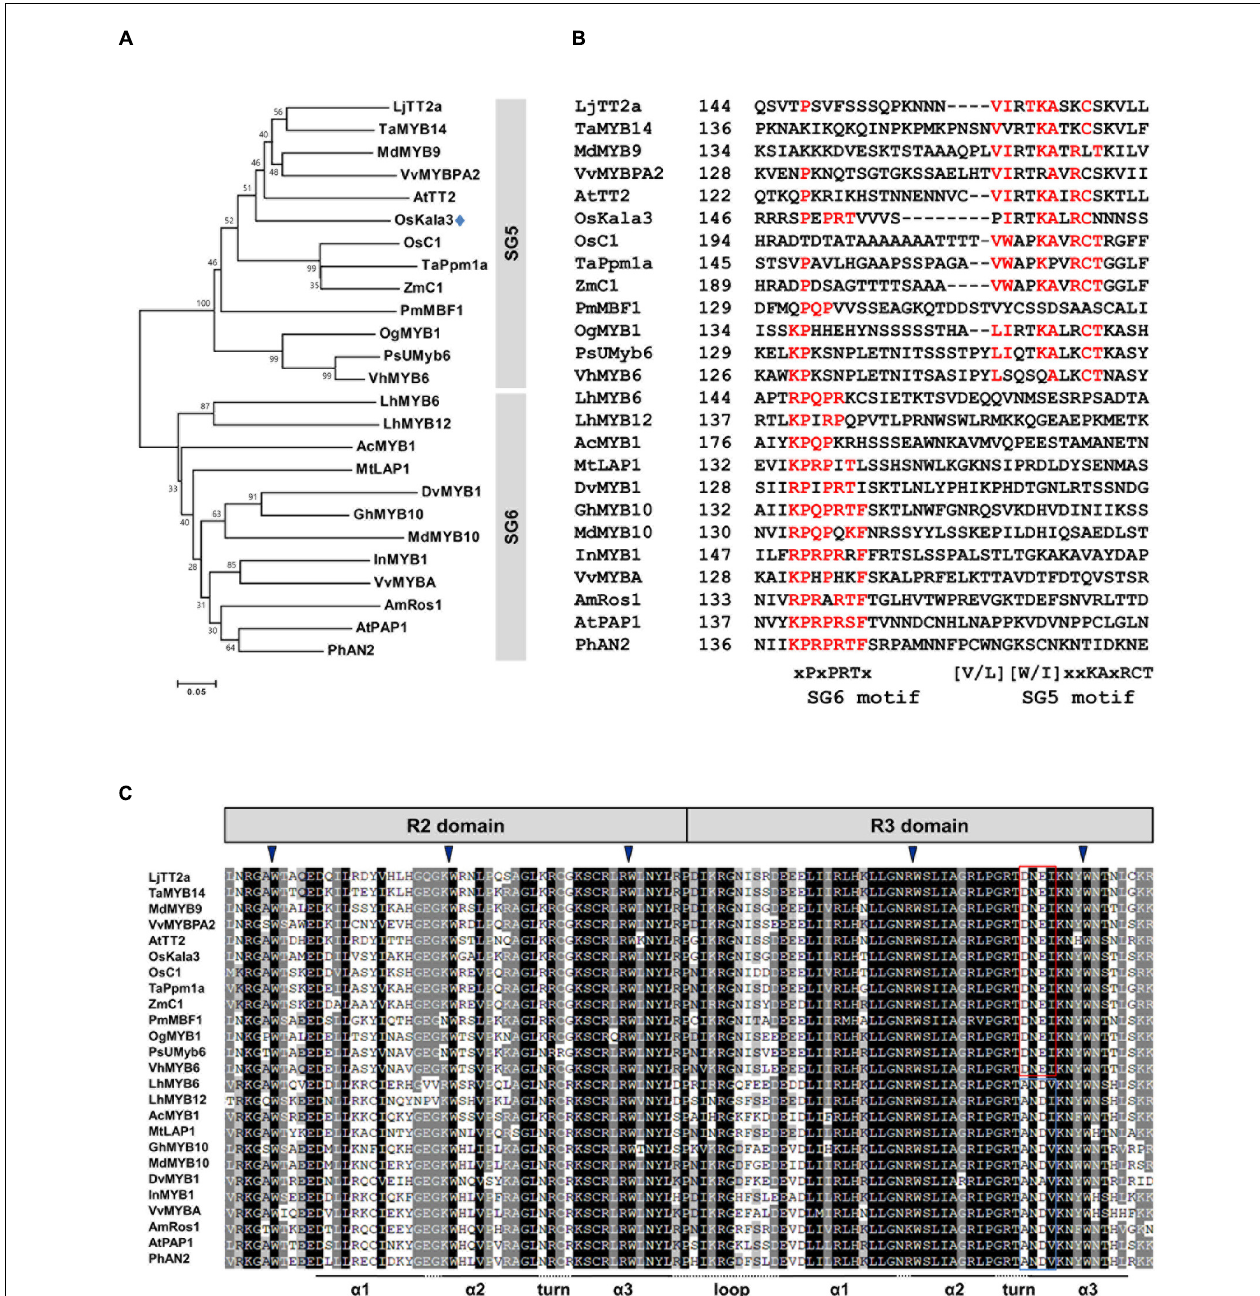
FIGURE 2 | Phylogenetic relationships between anthocyanin biosynthetic regulators in rice and other species. (A) Phylogenetic tree of rice OsKala3 and R2R3 MYB proteins from other plants. The phylogenetic tree was constructed using the neighbor-joining method with MEGA6 software. GenBank database accession numbers are Allium cepa AcMYB1 (KX785130); Antirrhinum majus AmRos1 (ABB83826); Arabidopsis thaliana AtPAP1 (AAG42001), AtTT2 (CAC40021); Dahlia pinnata (syn. variabilis) DvMYB1 (AB601003); Gerbera hybrida GhMYB10 (CAD87010); Ipomoea nil InMYB1 (BAE94391); Lilium hybrida LhMYB6 (BAJ05399), LhMYB12 (BAJ05398); Lotus japonicas LjTT2a (AB300033); Malus × domestica MdMYB9 (ABB84757), MdMYB10 (ACQ45201); Medicago truncatula MtLAP1 (ACN79541); Oncidium Gower Ramsey OgMYB1 (ABS58501); Oryza sativa OsC1 (BAD04024), OsKala3 (BAA23339); Petunia × hybrida PhAN2 (AAF66727); Phalaenopsis schilleriana PsUMyb6 (FJ039860); Picea mariana PmMBF1 (U39448); Trifolium arvense TaMYB14 (AFJ53053); Triticum aestivum TaPpm1 (MG066451); Vanda hybrida VhMYB6 (ADQ57817); Vitis vinifera VvMYBA (BAD18977), VvMYBPA1 (AM259485); Zea mays ZmC1 (AAA33482). (B) Multiple sequence alignment of part of the C-terminal region of the R2R3-MYB sequences, showing the SG5 and SG6 motifs. Amino acids matching either the SG6 motif or the SG5 motif are indicated in red. The starting amino acid position of the sequences is given in the second column. (C) Multiple sequence alignment of the R2 and R3 domains across R2R3 MYB proteins shown in (A) . The conserved residues of DNEI and ANDV are represented using the red and blue boxes, respectively. Inverted blue triangles indicate the conserved residues forming the inner hydrophobic core of the R2 and R3 domains.